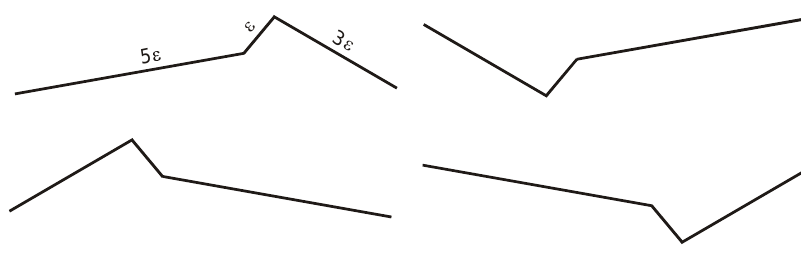
Figure 13. Four possible options of generator’s arrangement.